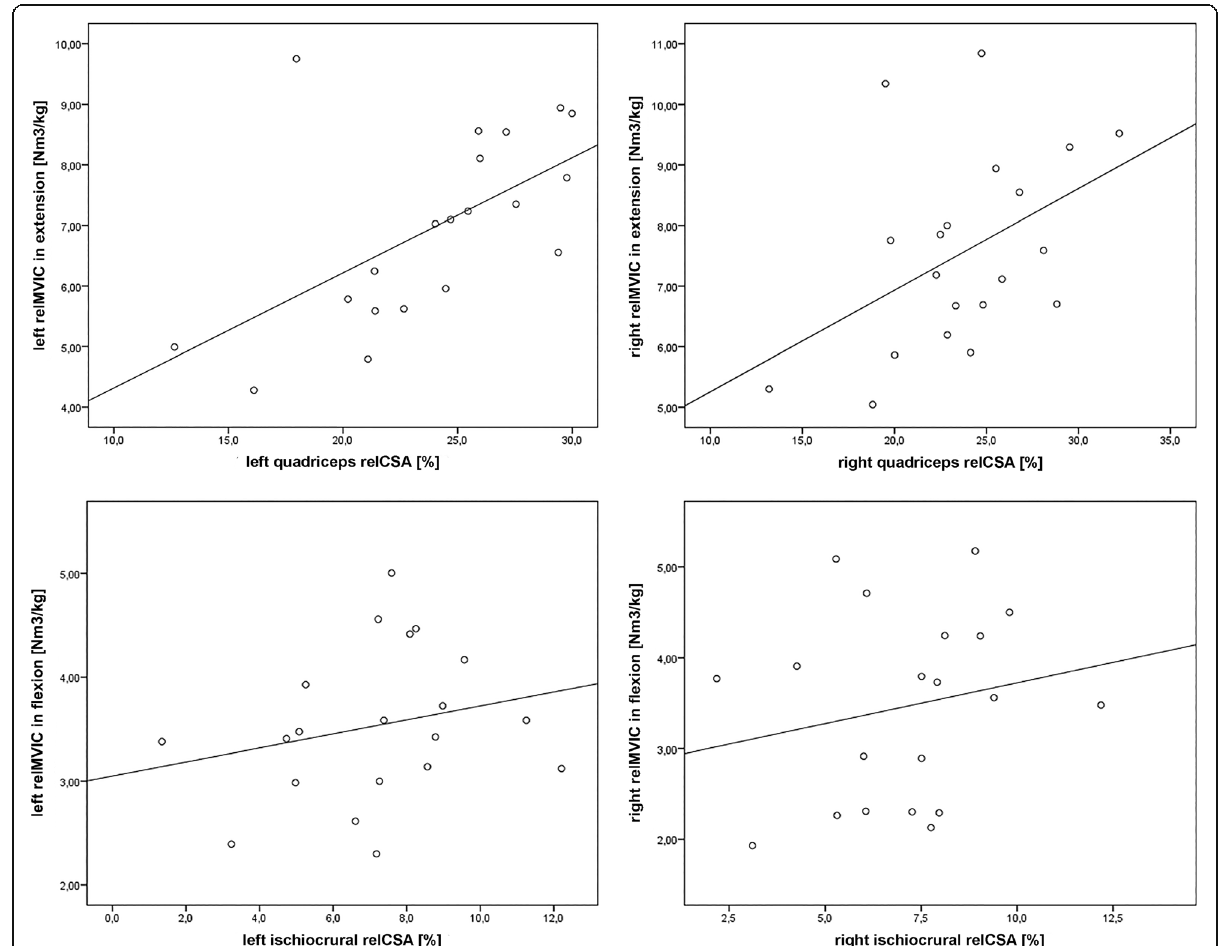
Fig. 4 Correlation between the relative cross-sectional area (relCSA) and relative maximum voluntary isometric contraction (relMVIC). Plots showing the association between the left or right relMVIC in extension or flexion (in N*m 3 /kg) and the relative CSA (in %) of the left or right quadriceps or ischiocrural